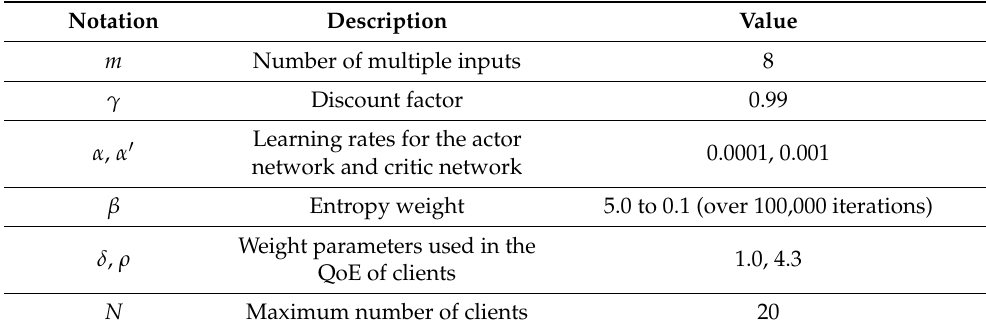
Table 1. Parameter description for the multi-agent